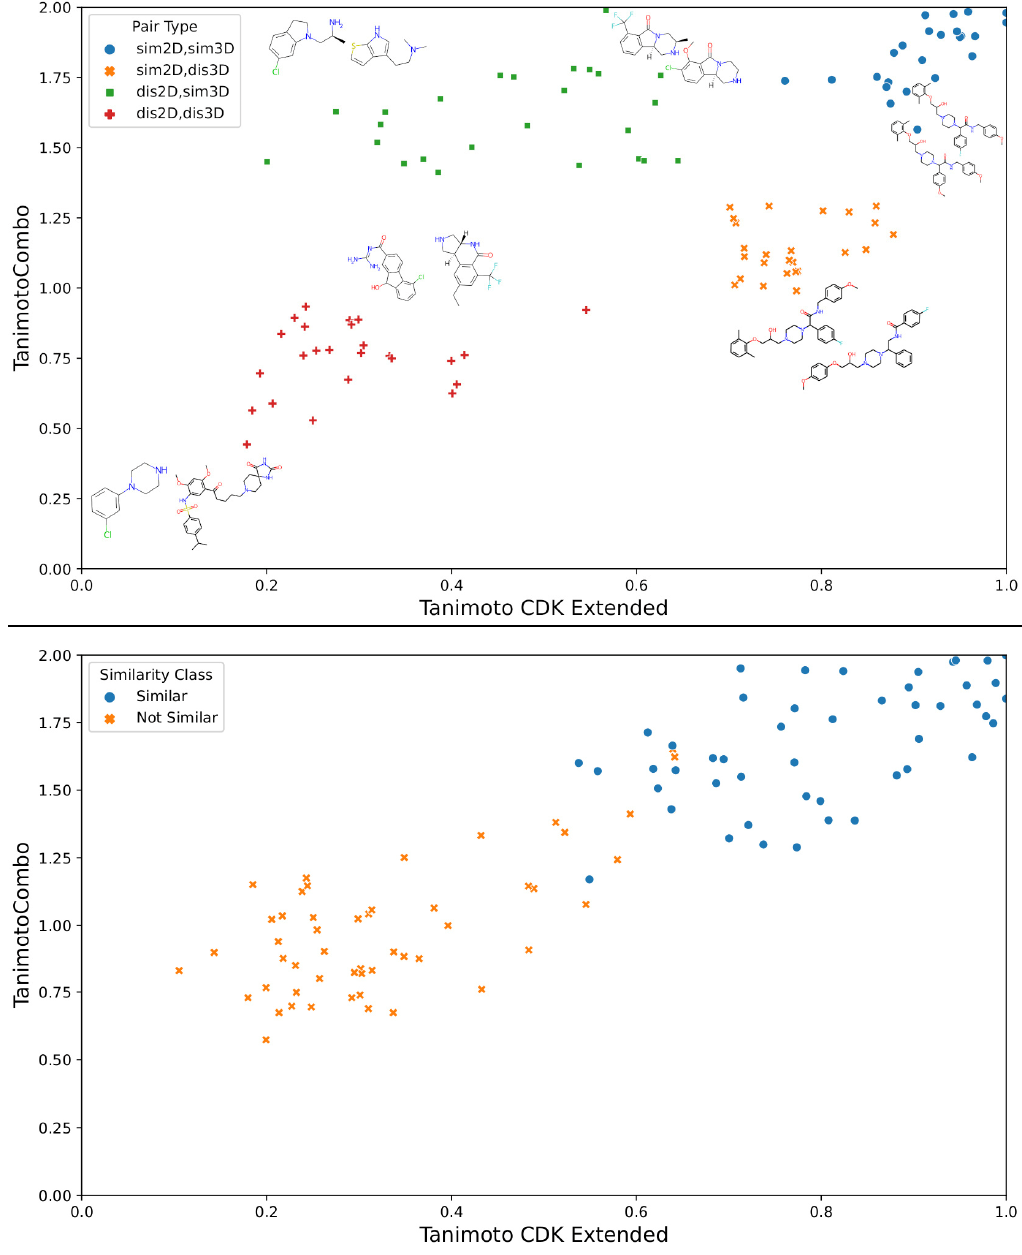
Figure 1. 2D (t XT )/3D (t CS ) similarity plots of MP ( top ) included in the survey and ( bottom ) studied by Franco et al. [11]; 2D structures of some representative molecular pairs are shown ( top ).